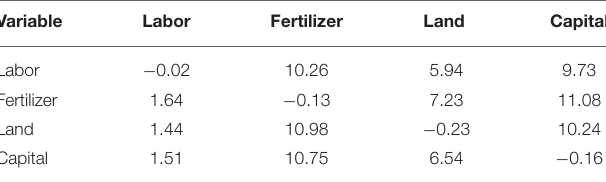
TABLE 7 | Derived price elasticities of demand for inputs. Variable